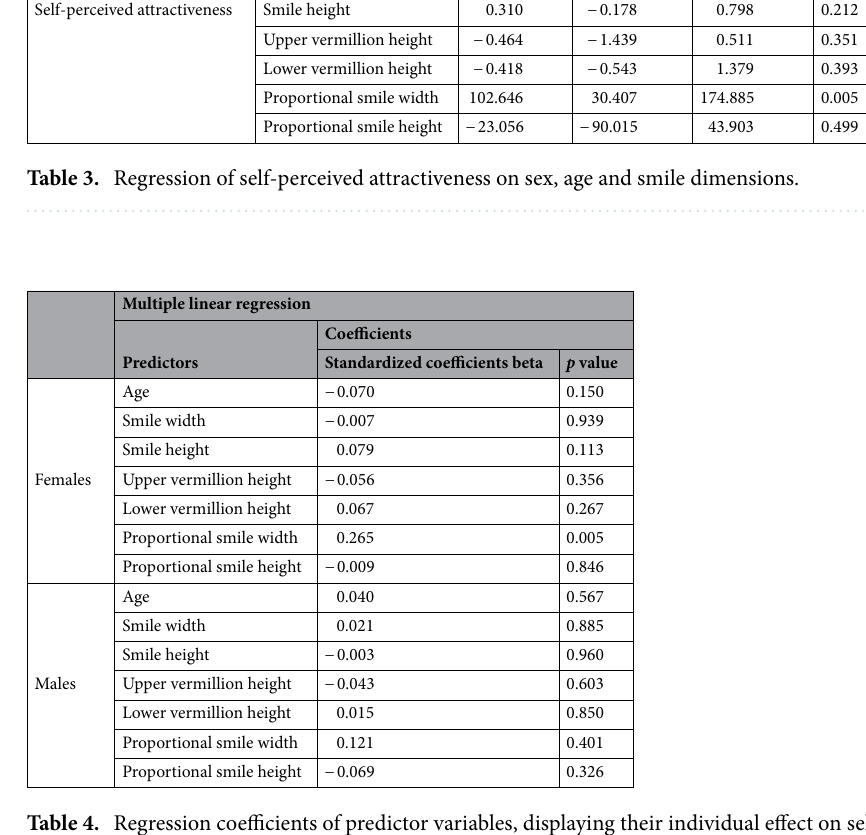
Table 4. Regression coefficients of predictor variables, displaying their individual effect on self-perceived smile attractiveness in females and males.